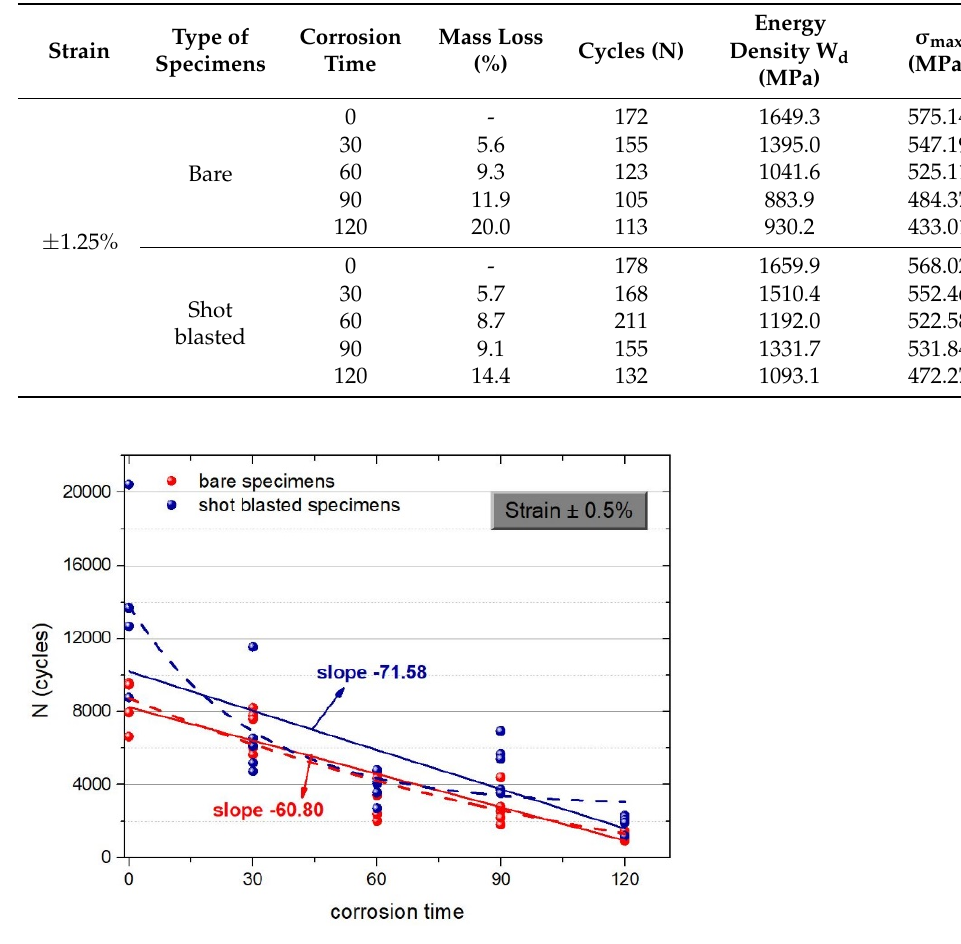
Figure 5. Fitting curves of number of cycles in function with corrosion time for imposed deformation ±0.5%.